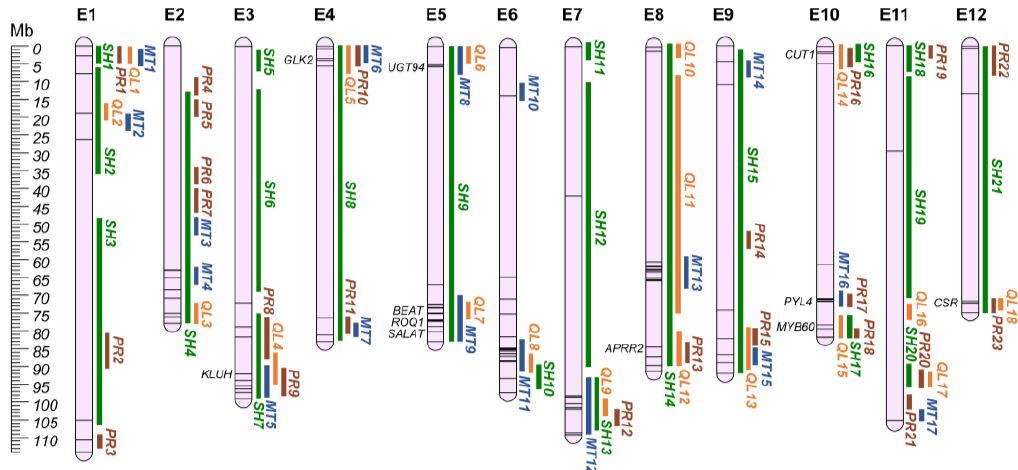
Figure 4. Fruit-related QGRs chromosome map (E1 – E12). Green: Shape QGRs (SH); Brown: Productivity (PR); Orange: Quality (QL); Blue: Metabolites (MT). Main candidate genes are reported in italics, while information about the other candidates (represented by bars on the chromosomes) are shown in Table